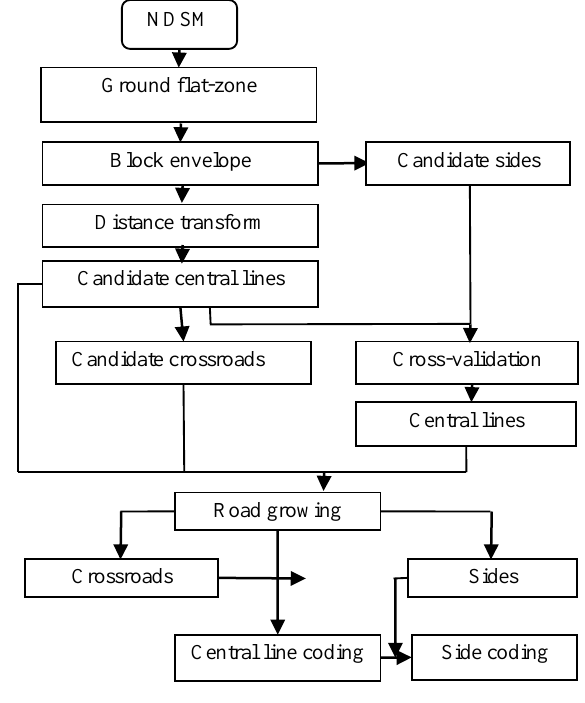
Figure 1. Flow chart of the